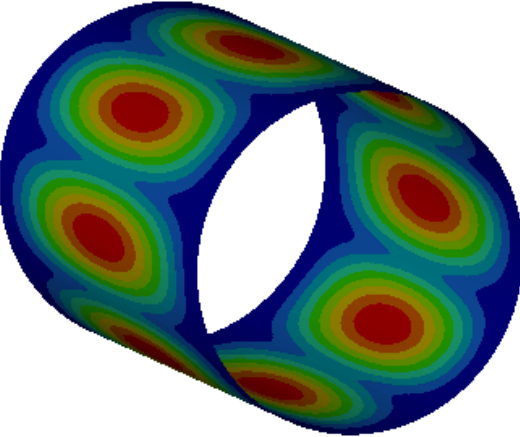
Figure 9. Optimized cylinder first buckling mode, n = 4, using HyperMesh.